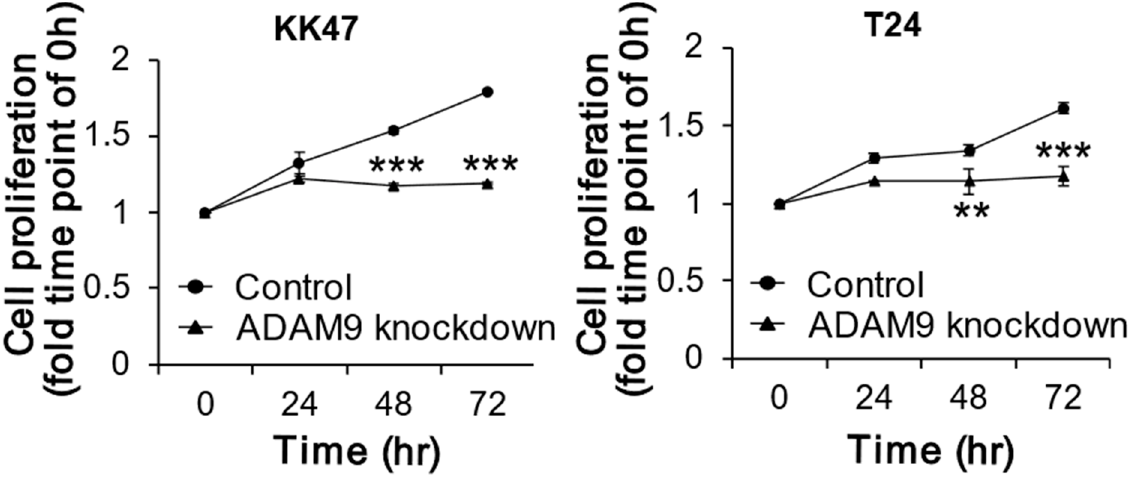
Figure 2. Comparison of cell proliferation between control and ADAM9 knockdown. In vitro cell proliferation assays in KK47 and T24 cell lines treated with Lipofectamine 2000 and 5 nM siRNA against human ADAM9 (n = 3). Group of ADAM9 knockdown significantly inhibited cell proliferation in KK47, and T24 after 48 and 72 h treatment ( p < 0.05) (** p < 0.01, *** p < 0.001).